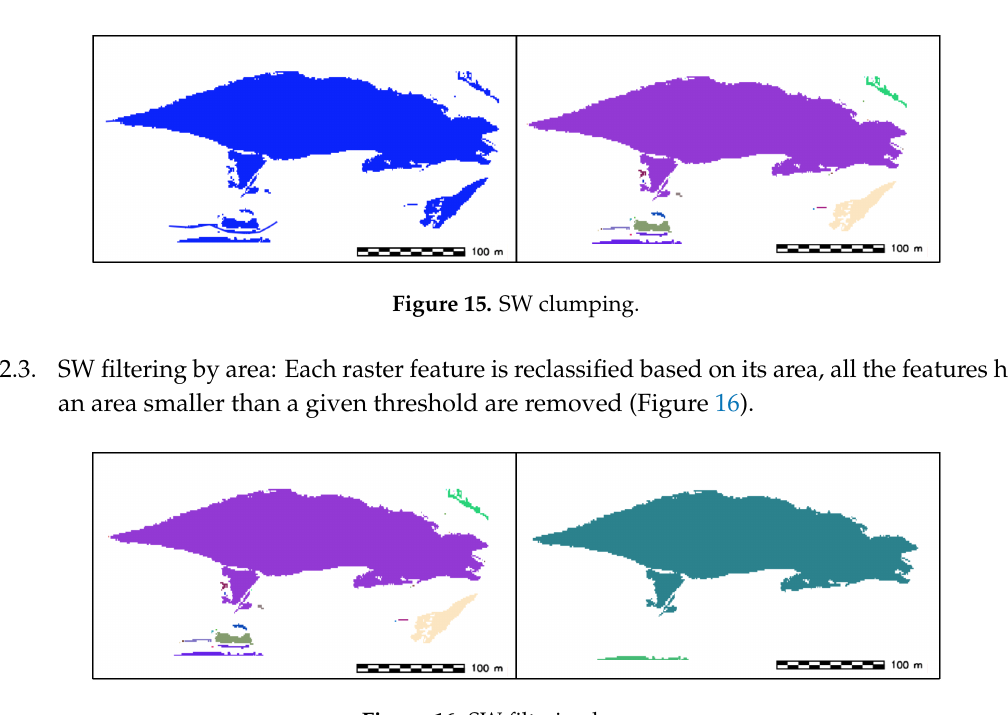
Figure 16. SW filtering by area.